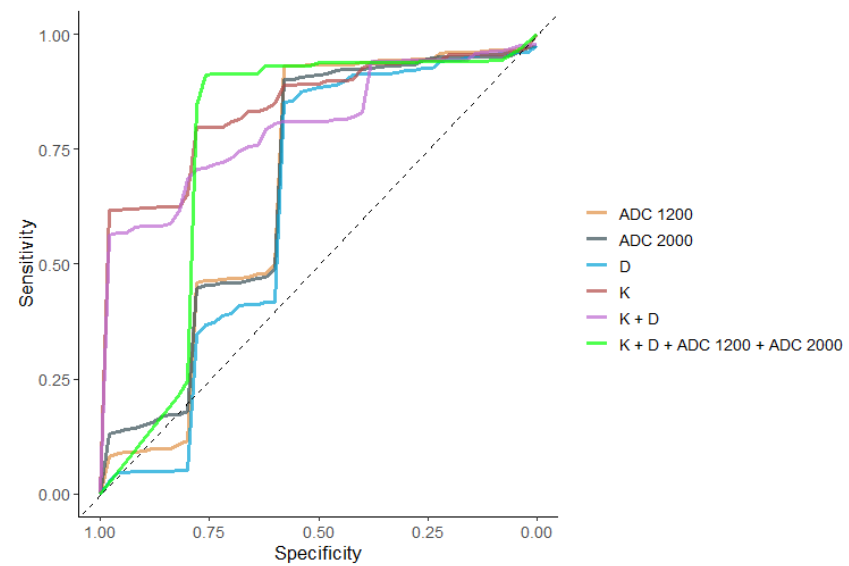
Figure 7. ROC curves of the performance of D app , K, ADC 1200 and ADC 2000 , K + D, and K + D + ADC 1200 + ADC 2000 for differentiating GS ≤ 3 + 3 and GS ≥ 3 + 4 tumors in the transitional zone.